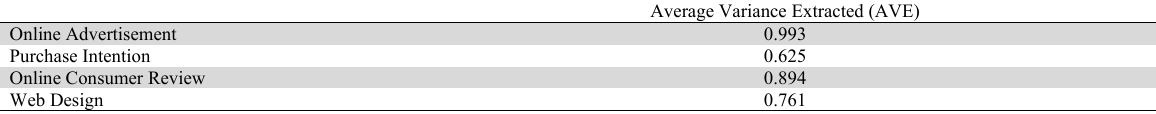
Average Variance Extracted (AVE)